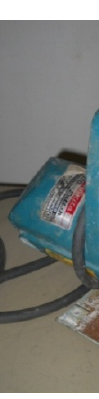
Figure 2. Circular saw used to create the damages.